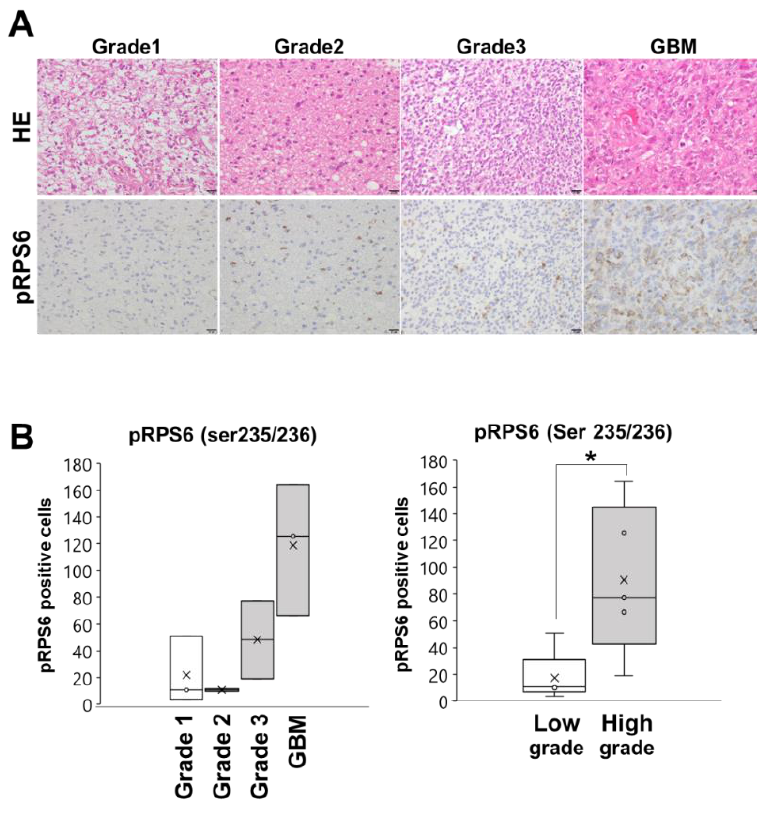
Figure 4. RPS6 phosphorylation in glioma tissues. ( A ), Representative images of hematoxylin and eosin (HE) staining (upper panel) and immunohistochemical staining for pRPS6 expression (lower panel) in human glioma tissues Grade 1, 2, 3, and 4 (GBM). Bar: 20 µm, ( B ), A graph showing the positive cells of pRPS6 in each grade of glioma patients (values are presented as mean ± SD of triplicate samples. * p < 0.05).